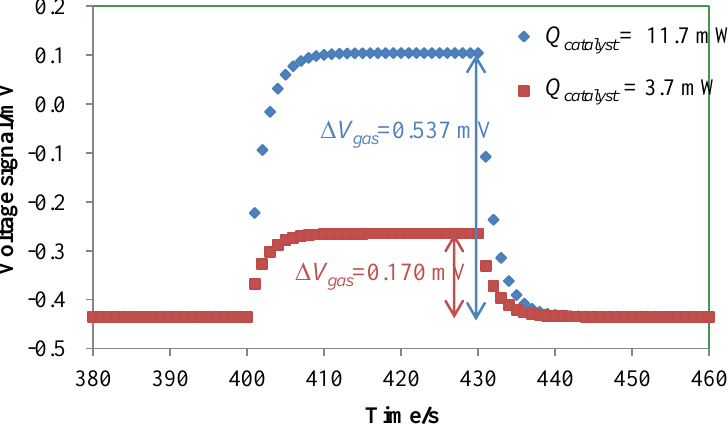
Figure 7. Simulated response curve of the TGS as a function of the catalyst thickness d . The catalytic combustion heat Q catalyst